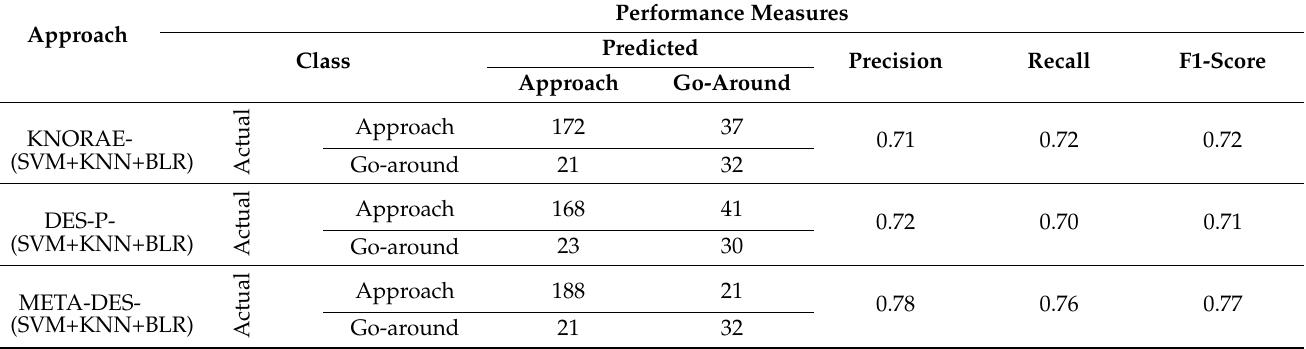
Table 10. Comparison of performance measures of DES based on the pool of heterogeneous